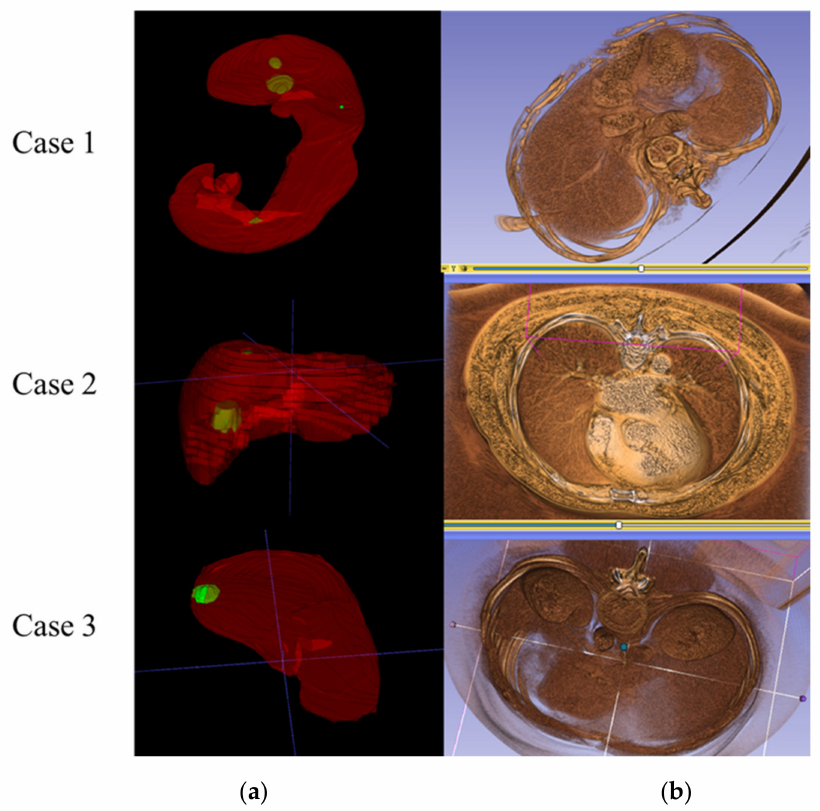
Figure 6. Three-dimensional segmentation of ( a ) ITK-Snap and ( b ) 3D slicer for medical image